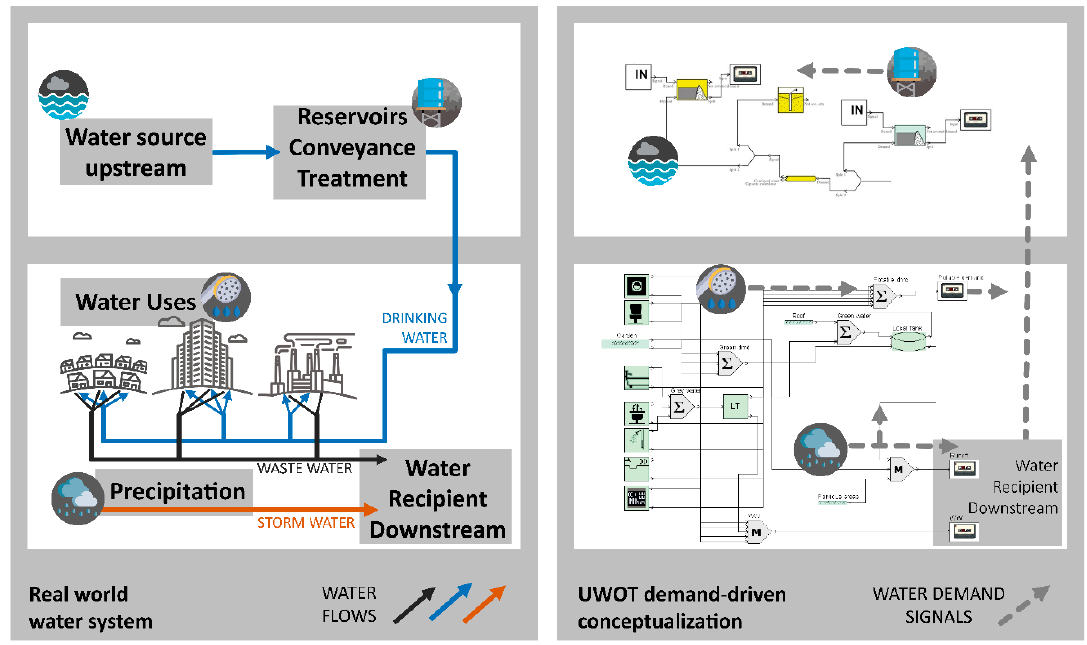
Figure 1. The flows seen in real water systems ( left ) as well as in the UWOT demand-driven conceptualization ( right ).